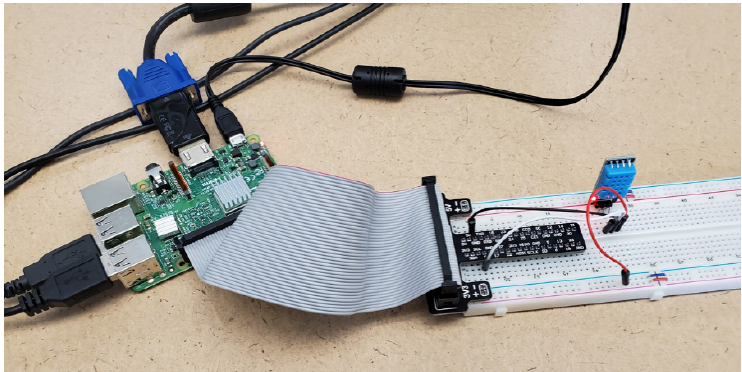
Figure 1. Prototype Raspberry Pi IoT (Internet of Things) device used for the testbed.